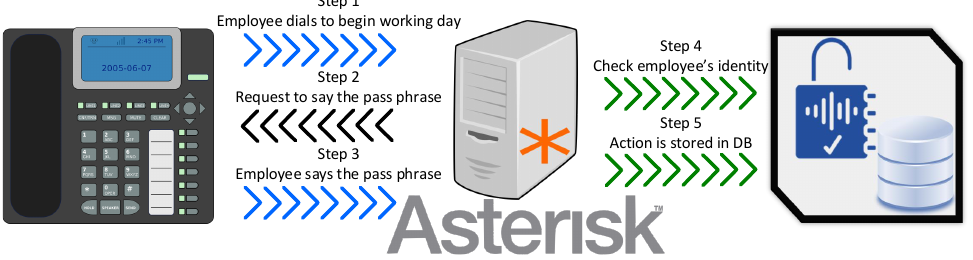
Figure 4. Architecture of the projects to deploy a presence control